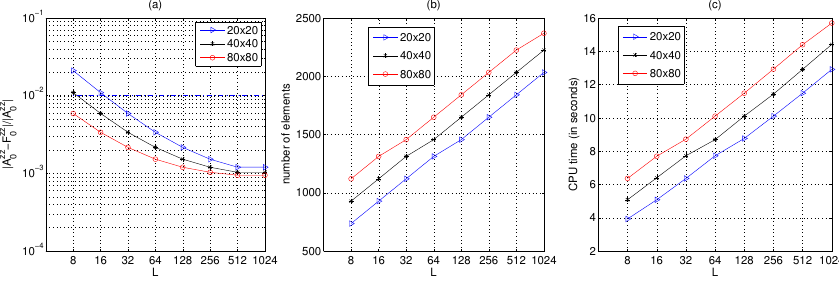
Figure 7. TEST 3 on hexahedron Mesh1, for 20 × 20, 40 × 40 and 80 × 80 contact grids. (a) Relative error at the origin for different domain sizes L . The dashed line indicates the target accuracy defined by Eq. (3.1). (b) Numbers of elements. (c) CPU time in seconds.